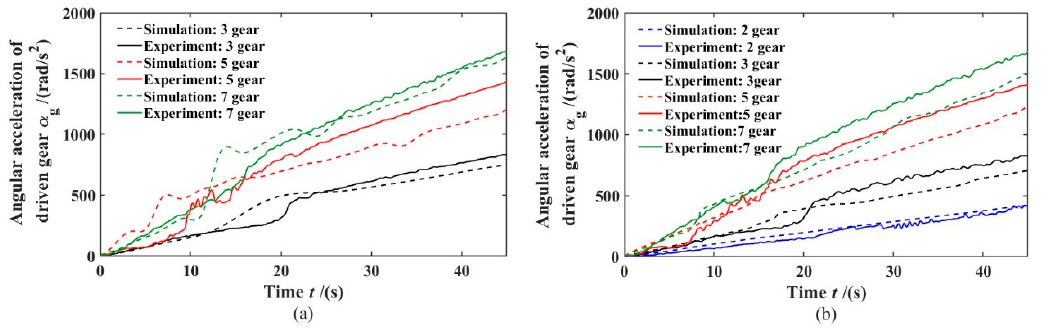
Figure 9. Angular acceleration amplitude of idler gear: (a) 1st gear; (b) 1st gear pre-selection 4th 300